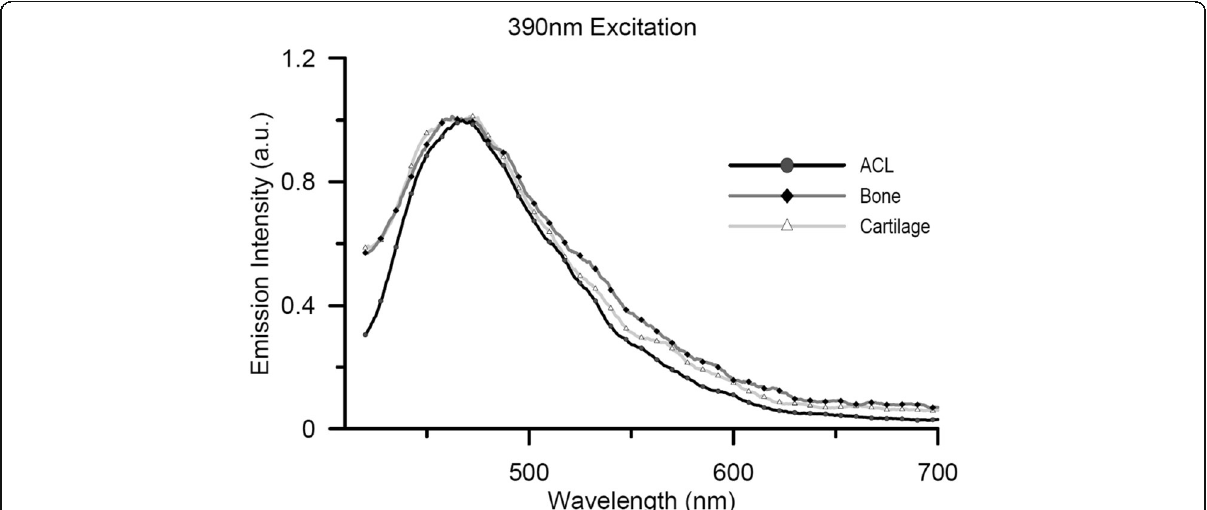
Fig. 3 Normalized bovine emission curves of ACL, Bone and Cartilage at 390 nm excitation. Note that the curve between ACL and Bone deviates around 525